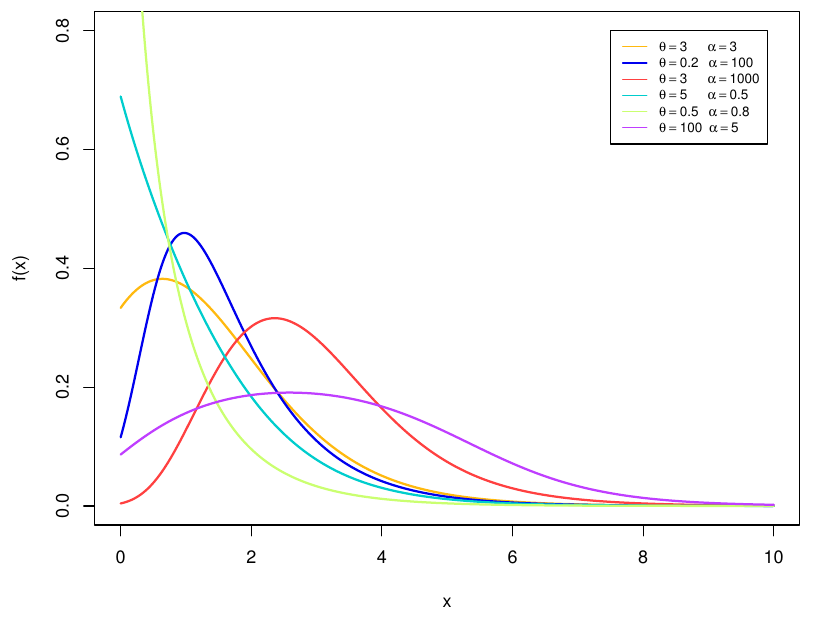
Figure 1. Different plots of the PDF of the LTAPEx distribution for various values of θ and α with β = 1.